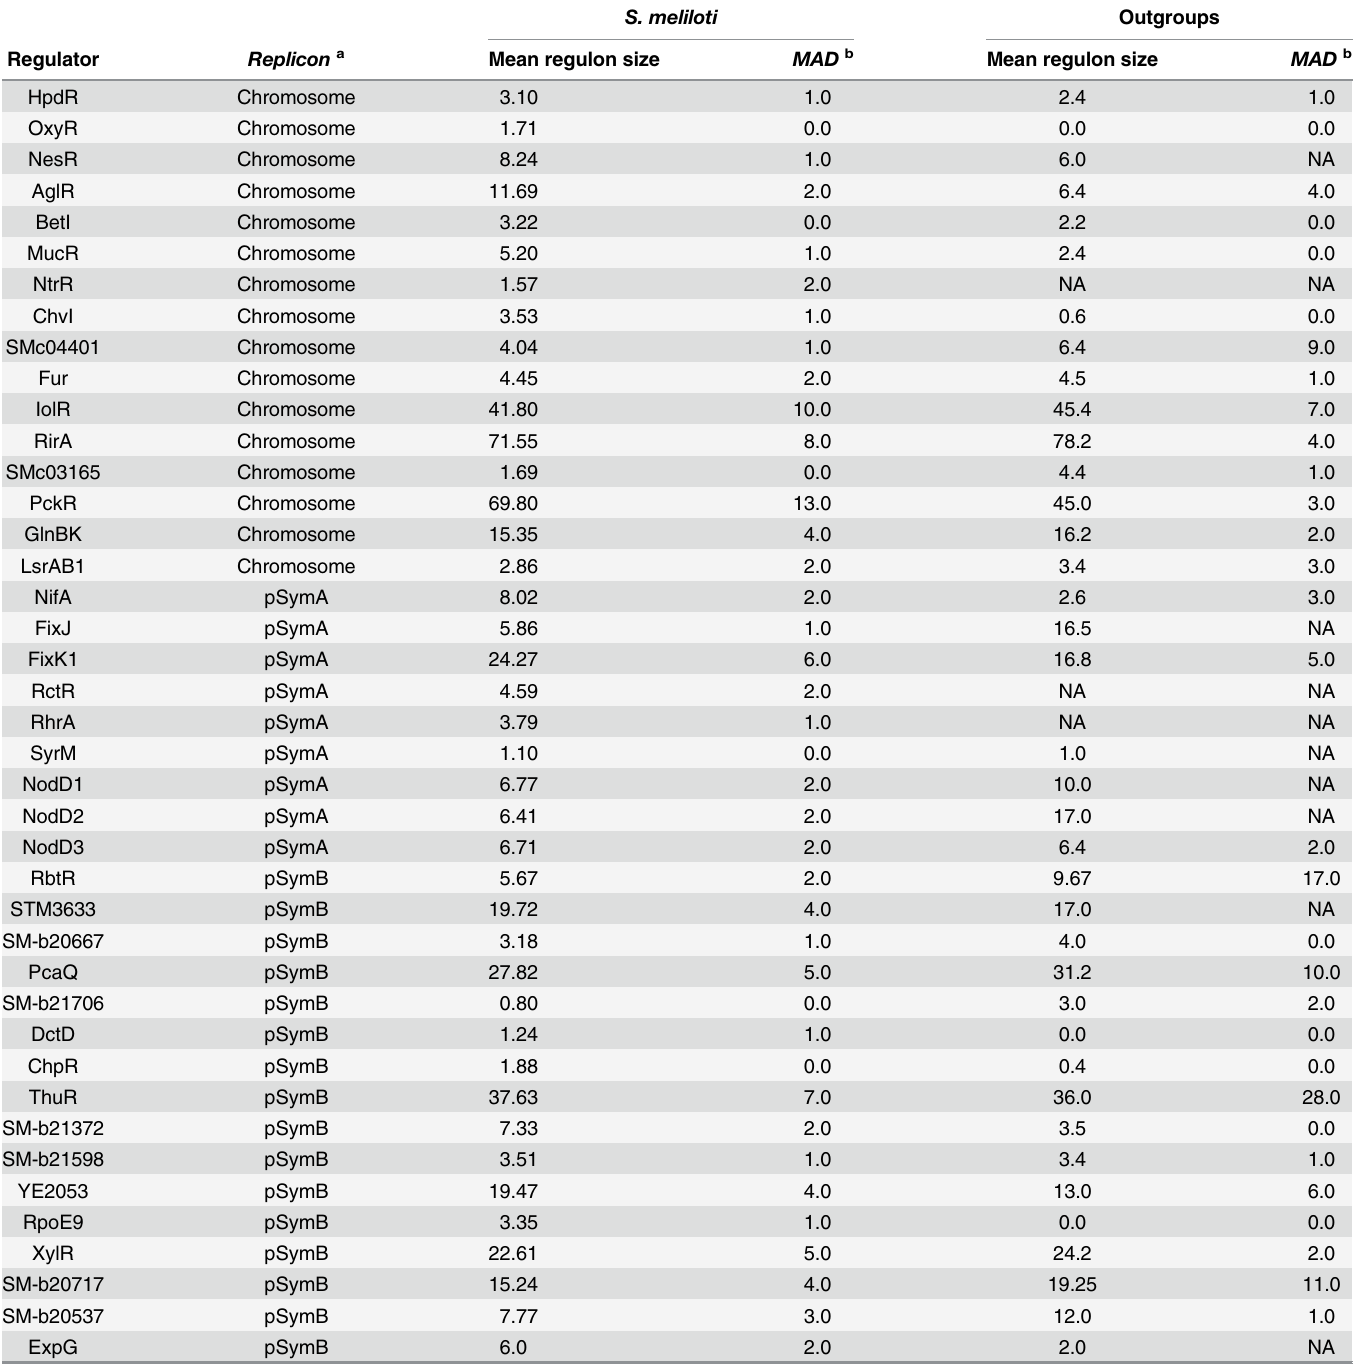
Table 1. Regulon downstream genes.